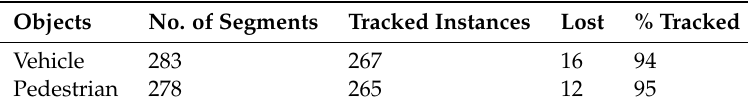
Figure 14. Tracking multiple objects over time. Table 6. Results of